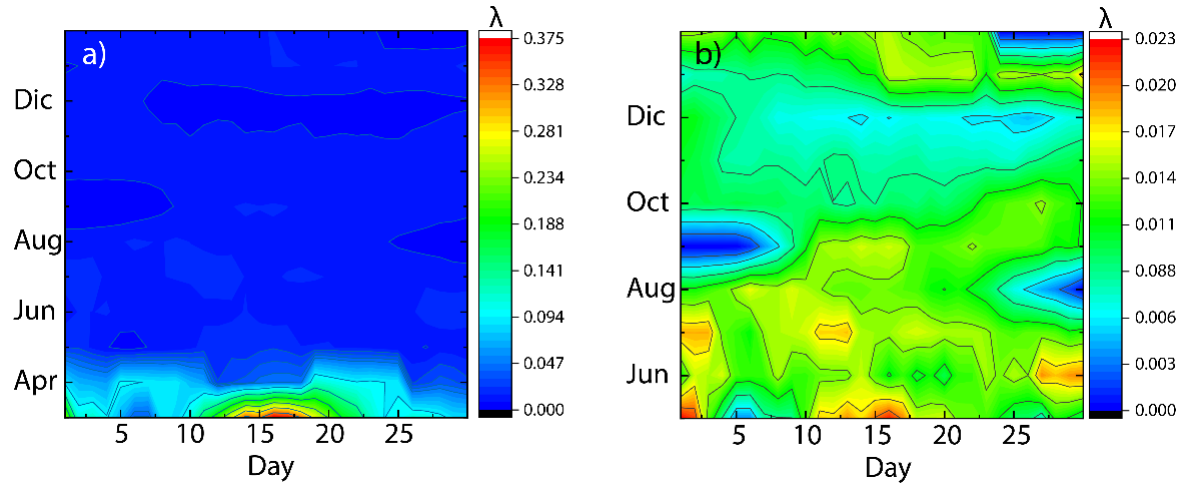
Figure 9. The growth rate coefficient of Equation 11 is represented as a surface-color plot vs 30-days and 12-months. (a) the growth rate in a one-year window and (b) the growth rate from May 1, 2020, to February 28,